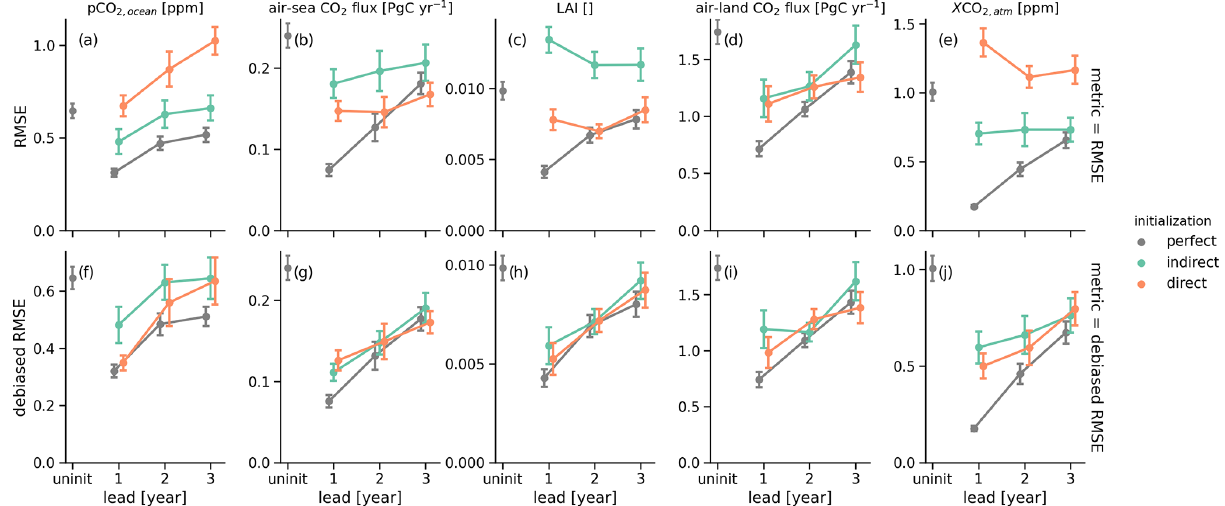
Figure H1. The same as Fig. 6 but with leaf area index (LAI) instead of carbon vegetation pools (cVeg).